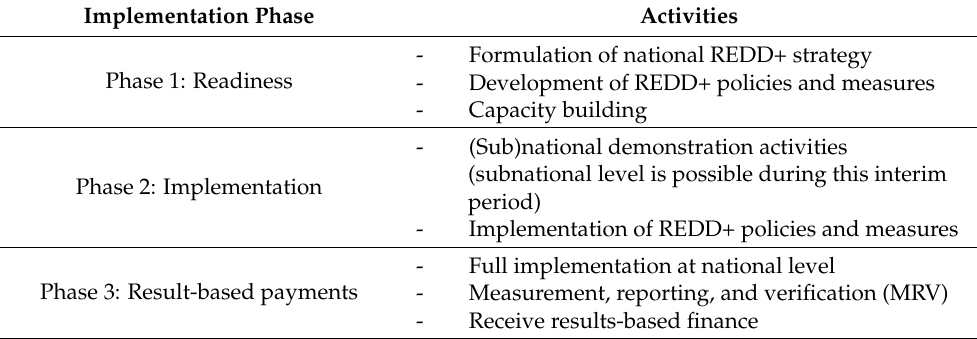
Table 1. REDD+ phased approaches